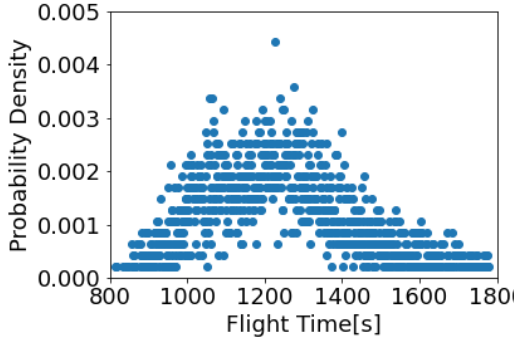
Figure 5. Service time distribution g av ( x )